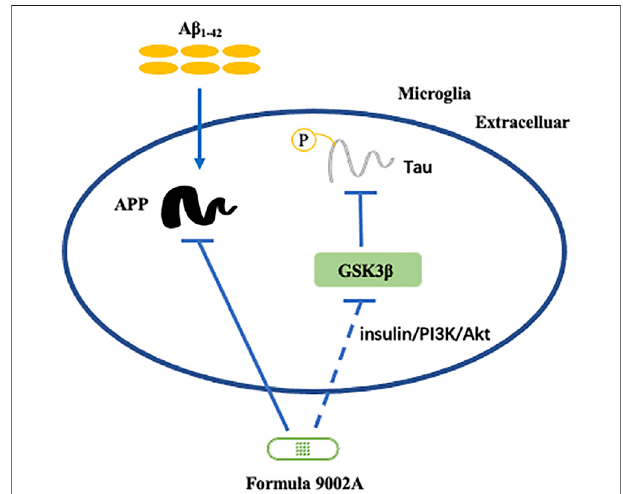
FIGURE 8 | The mechanism of Formula 9002A aimed at APP and GSK3 β for